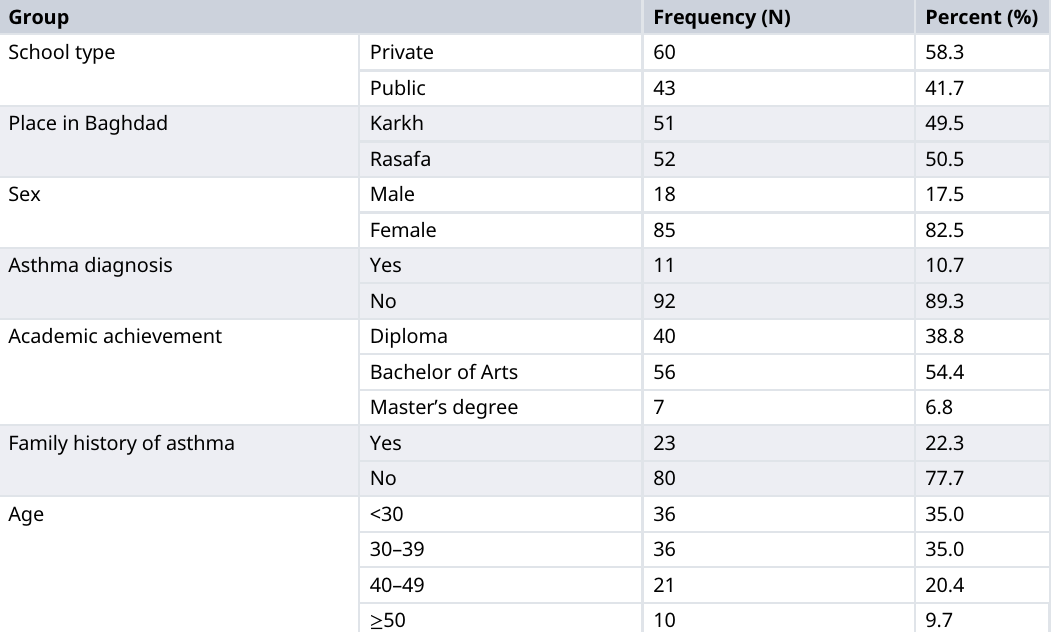
Table 1. Socio-demographic characteristics of teachers [Total (N) =